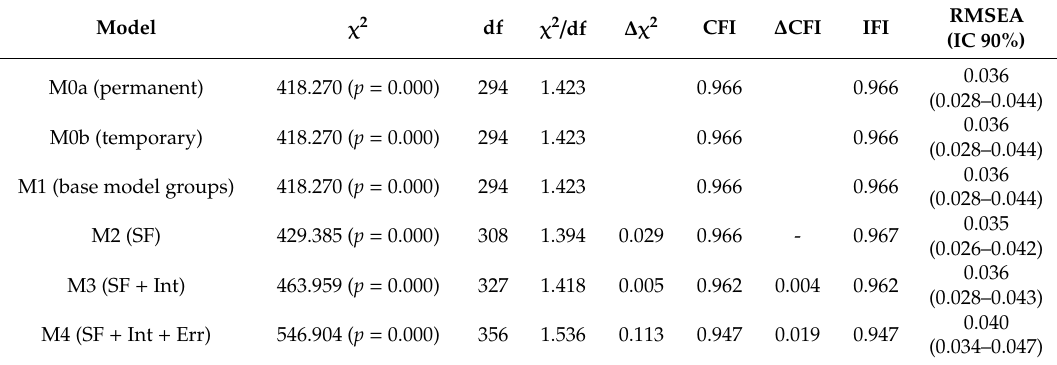
Table 4. Multi-group analysis of invariance by the type of contract (permanent / temporary).